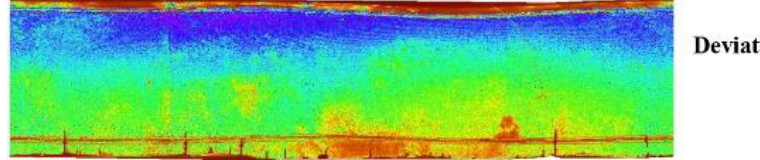
Figure 7: Comparison of the damage map from classical conservation works (a) and deviations maps acquired from differential point clouds